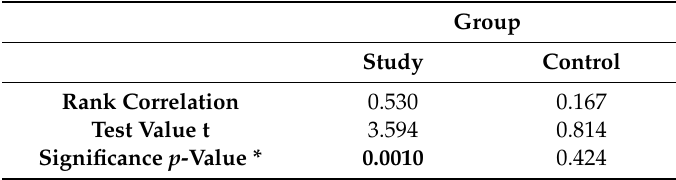
Table 1. Correlation between Perceived Stress Scale (PSS-10) result and Bruxism Index in the study and control